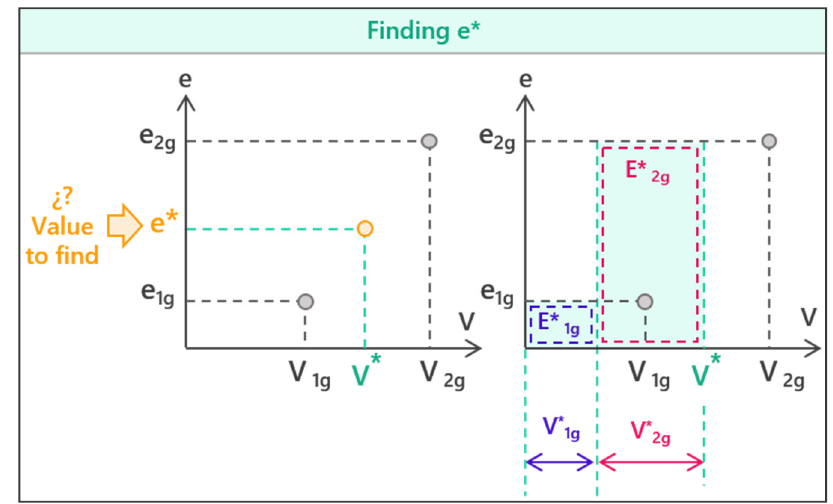
Figure 8. Finding the average specific energy e*.